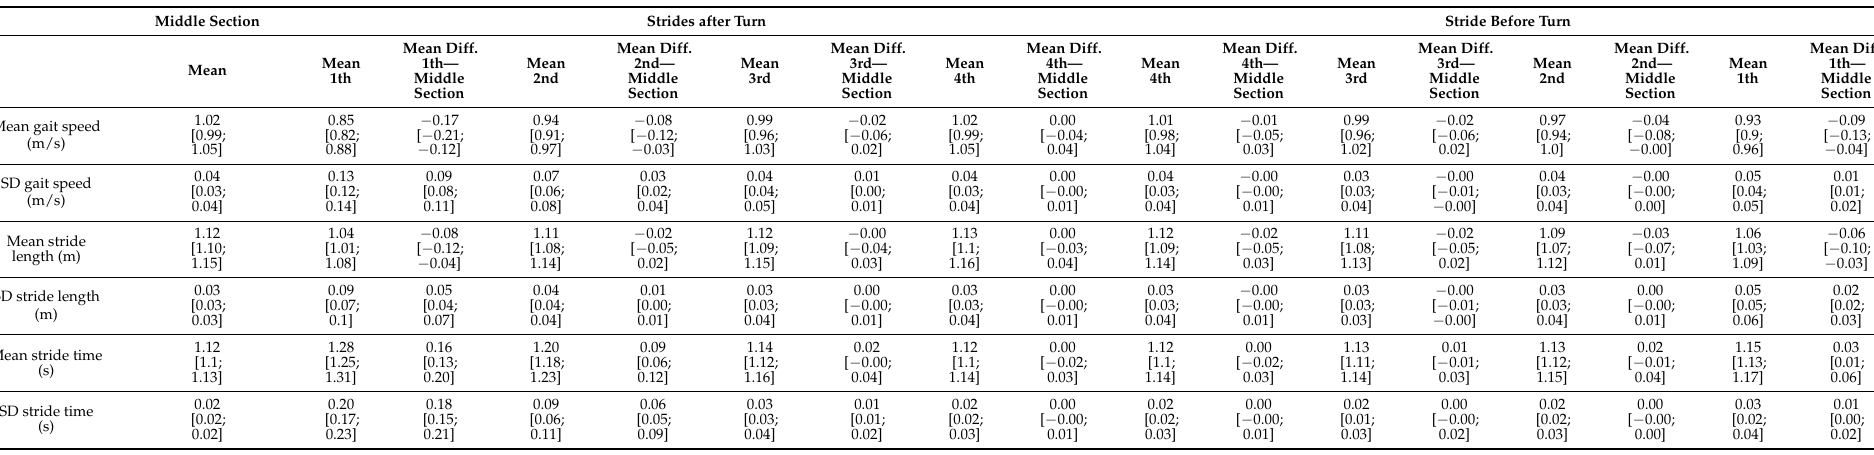
Table A2. Mean [99% CI] of gait speed, stride length, and stride time of the first four strides after and before a turn, and the middle section of the walking trajectory. Included are the difference (diff.) of these strides with the middle